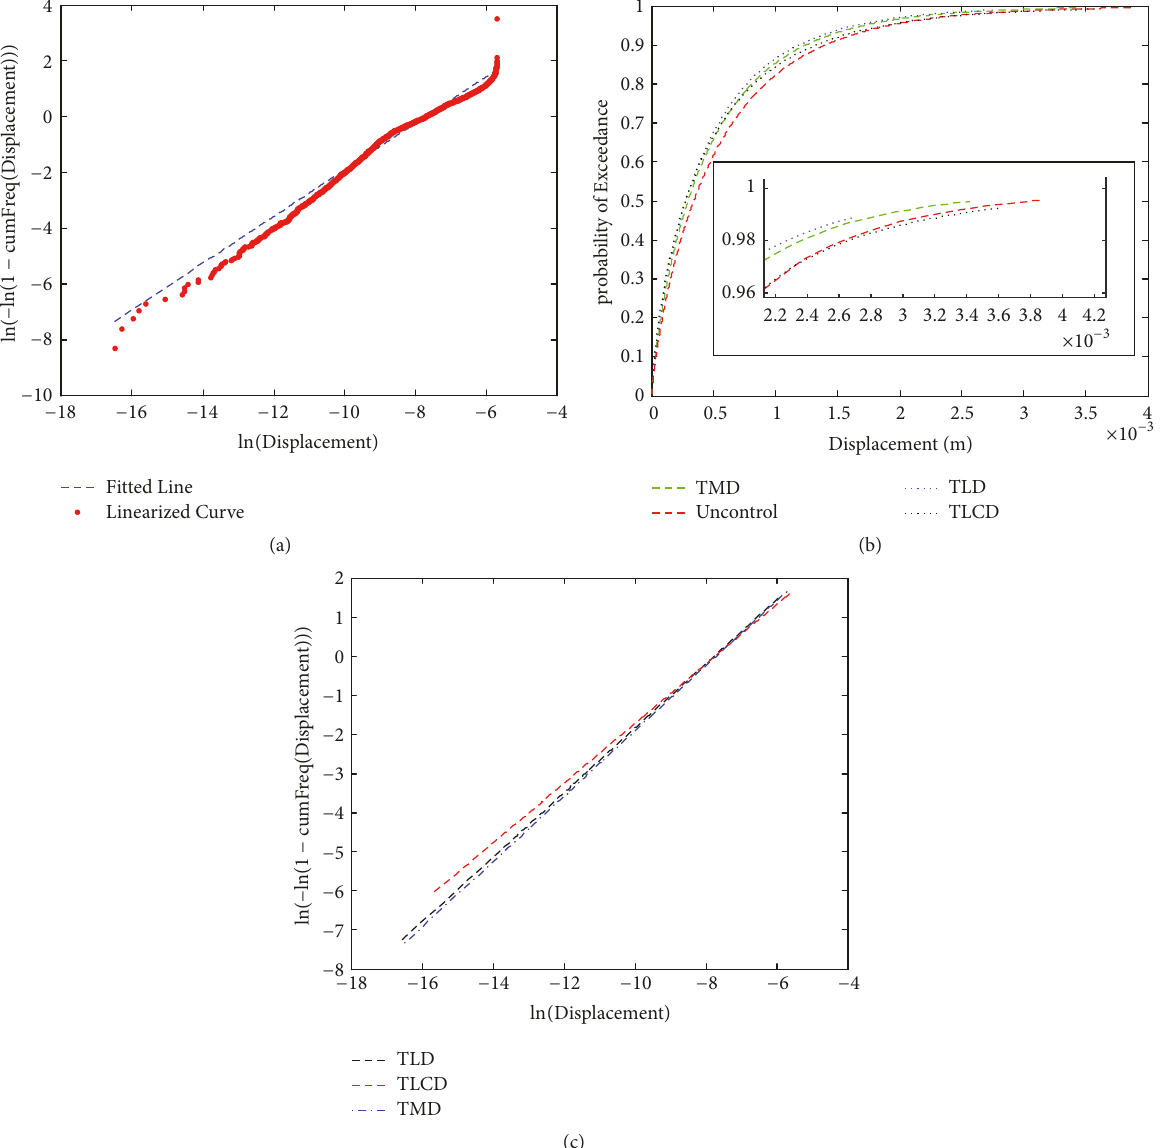
Fitted Line Linearized Curve